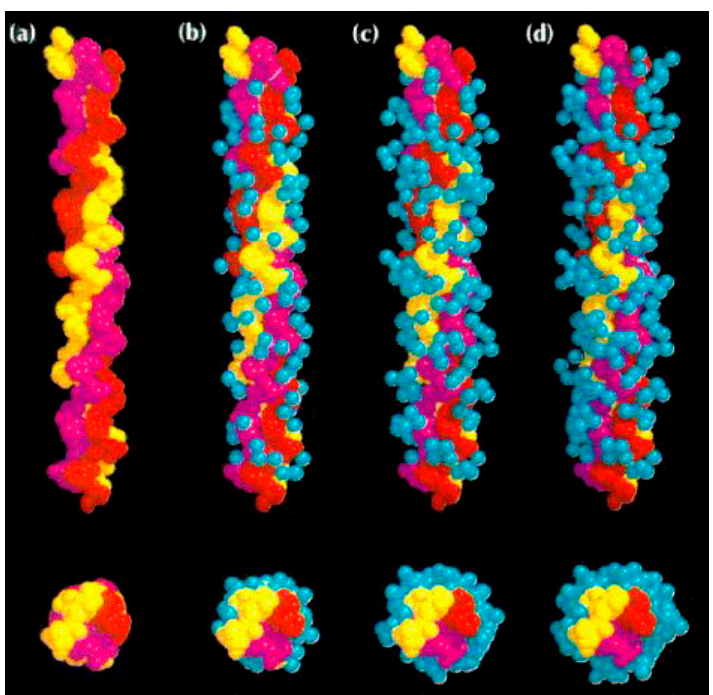
Figure 7. An example of a collagen peptide and its hydration shell: ( a ) in conventional science, biomolecules are usually represented only by this main chain on a black background, as if the biomolecular processes are happening in the vacuum; ( b – d ), a realistic picture, showing water hydration shells as an integral part [57] (Reprinted from Bella J, Brodsky B, Berman HM. Hydration structure of a collagen peptide. Structure 1995; 3:893–906, with permission from Elsevier).